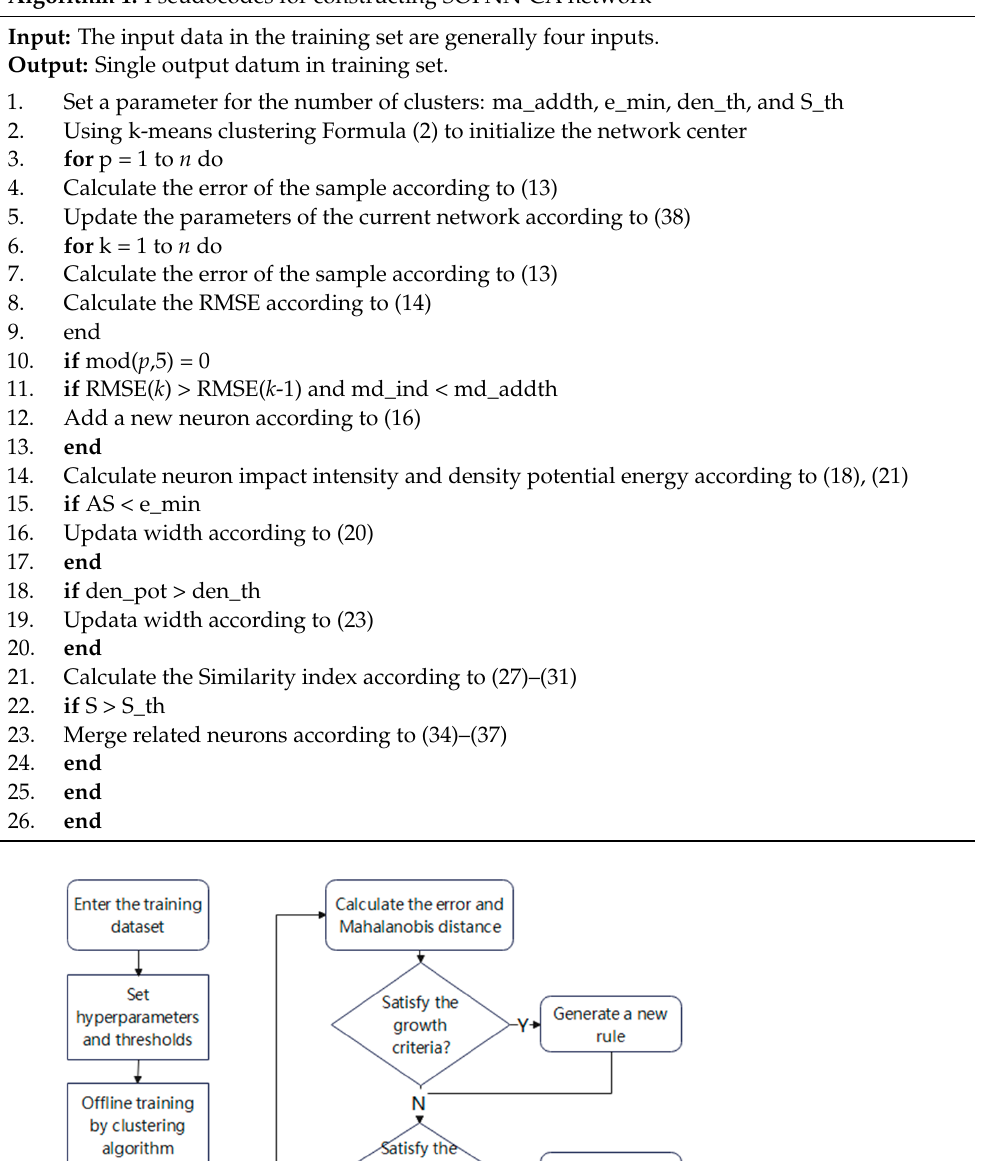
Algorithm 1: Pseudocodes for constructing SOFNN-CA network